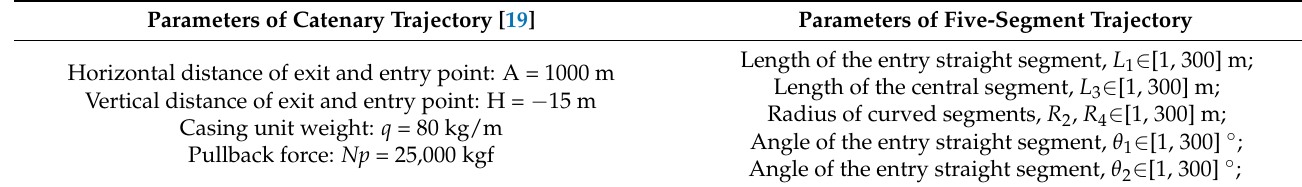
Table 1. Parameters and range setting.